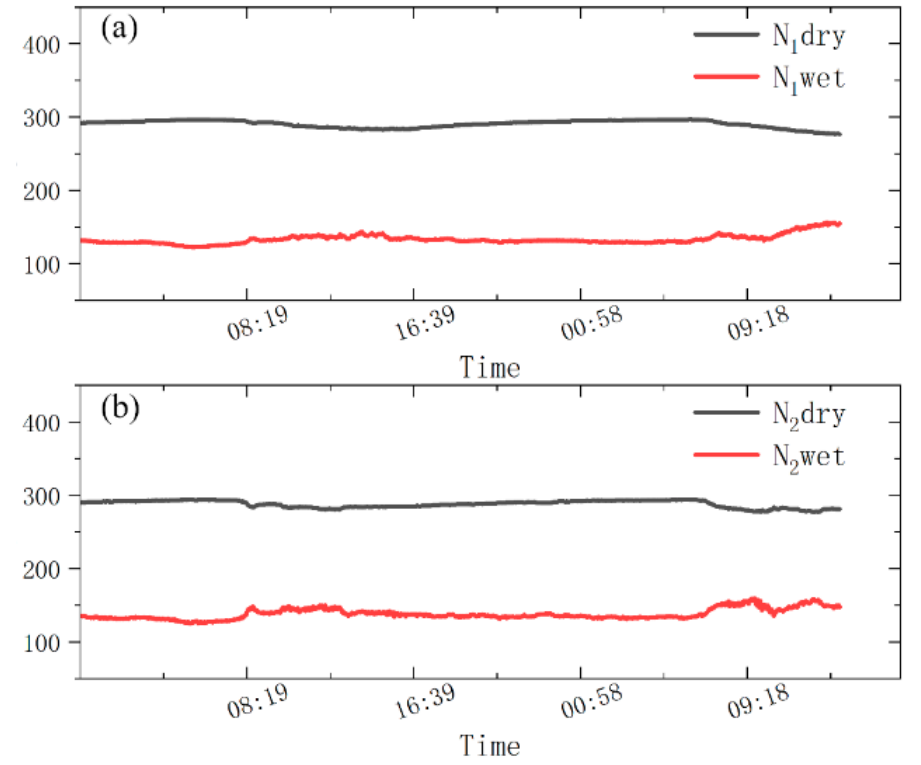
Figure 1. The dry and wet components of the refractivity index from 0:00 h on 28 September 2022 to 14:40 h on 29 September 2022. ( a ) The refractivity index of P1. ( b ) The refractivity index of P2.